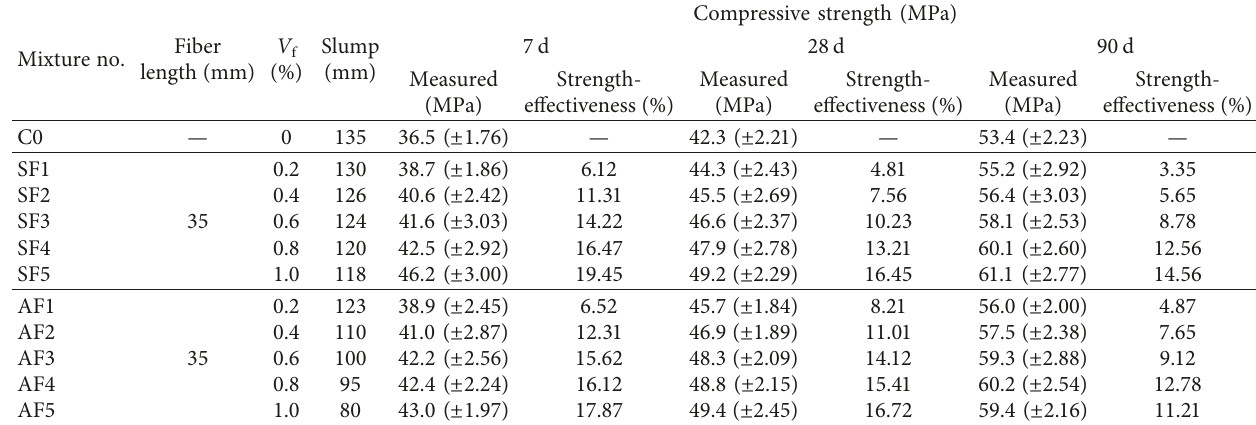
Table 5: Results of slump and compressive strength tests.